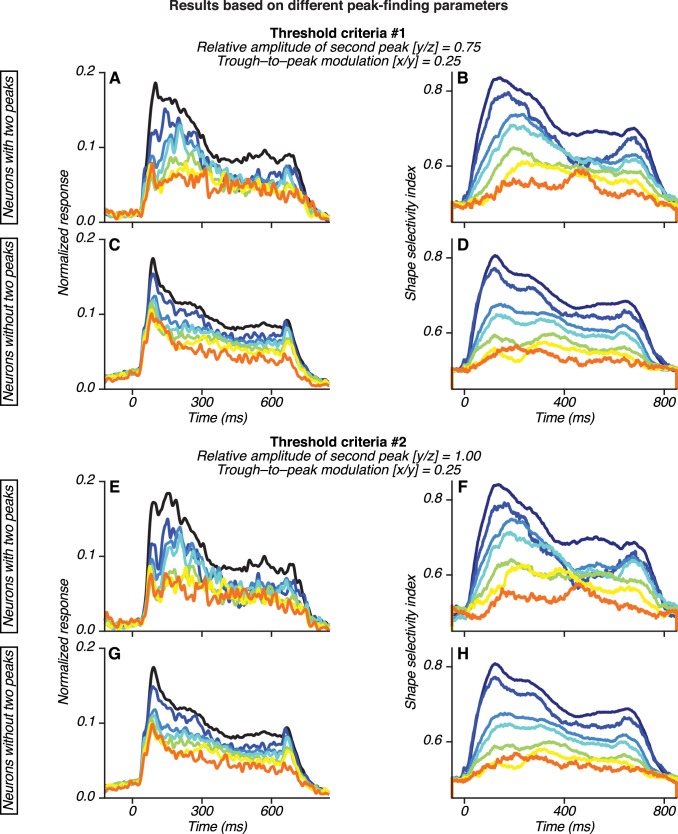
Dependence of observed V4 results on the peak-finding algorithm parameters.Population PSTHs (A, C, E, G) and average shape selectivity plots (B, D, F, H) for neurons with and without two peaks based on alternative parameter choices. Threshold criteria were: y/z > 0.75 and x/y > 0.25 for (A–D) and y/z > 1.0 and x/y > 0.25 for (E–H) (see Figure 8—figure supplement 3). In both cases, the second peak had to show a statistically significant increase in responses relative to the preceding trough (p<0.05, Bonferroni corrected). In (A–D) and (E–H), 26/85 and 16/85 neurons were classified as having two peaks. In both cases, results were similar to those shown in Figures 6 and 8. The median peak times for the second peak were 201 ms (A) and 196 ms (E). Shape selectivity was stronger and more delayed for neurons with two peaks.